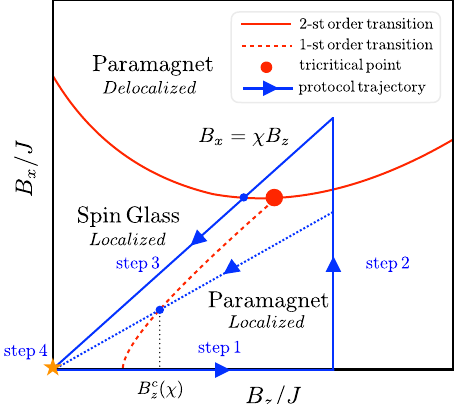
Fig.1|Phasediagramandtheprotocol. PhasediagramoftheHamiltonian(3)for a speci fi c reference state. The full red line indicates a second-order transition 51 between MBL and delocalized paramagnet; the dashed red line is the 1st order transition between the glass and MBL paramagnet. They meet at the tricritical point.Thebluelineswitharrowsrepresentoneoptimizationcycle.Thedottedblue line is a subcritical slope, χ < χ c , which most likely brings the system back to the initial reference